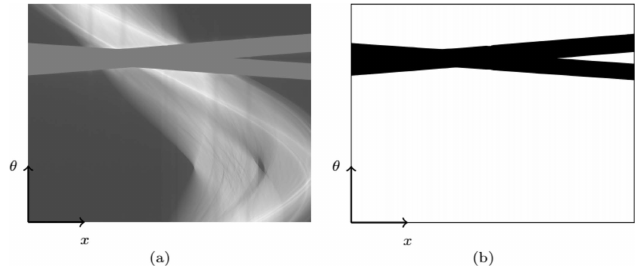
Figure 6 Missing-data area on the sinogram due to the columns of the loading gantry. ( a ) Sinogram slice. ( b ) Missing-data area (in black). In sinogram ( a ), the mean grey level of the available area is allocated to the missing- data area.